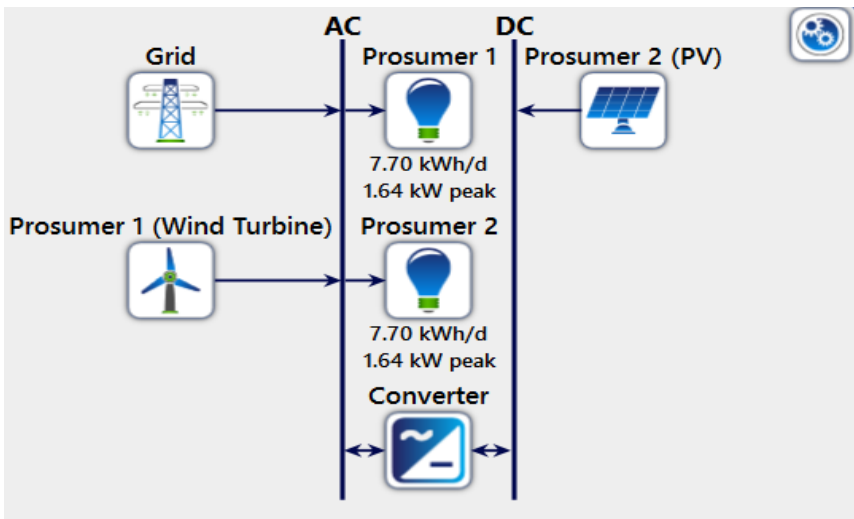
Figure 7. The microgrid schematic diagram designed in Homer Pro .